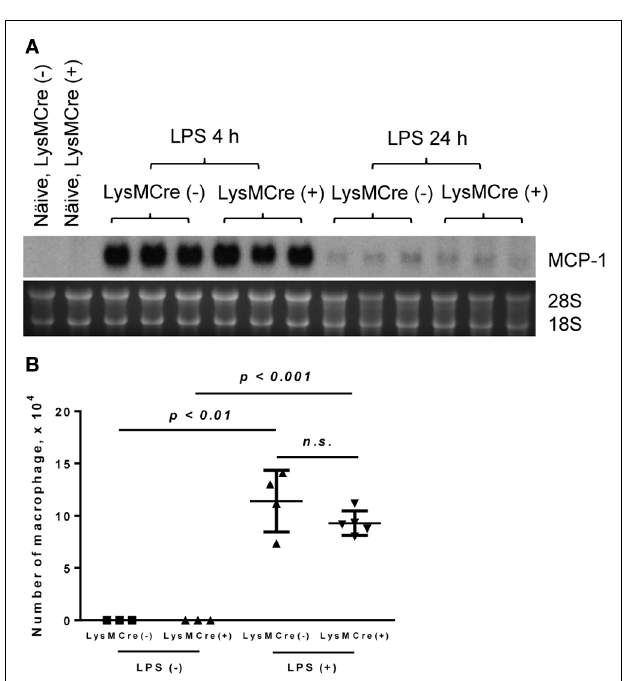
FIGURE 5 | MCP-1-deficiency in myeloid cells does not alter the production of MCP-1 in LPS-induced lung injury . Mice were exposed to LPS aerosol (100 or 1000 µ g/ml in 10ml PBS) for 30min. Four or 24h after LPS exposure, mice were euthanized by CO 2 and BALFs were collected. (A) The expression of MCP-1 mRNA was examined by Northern blotting. (B) The number of macrophages was counted. Data is presented as the mean ±